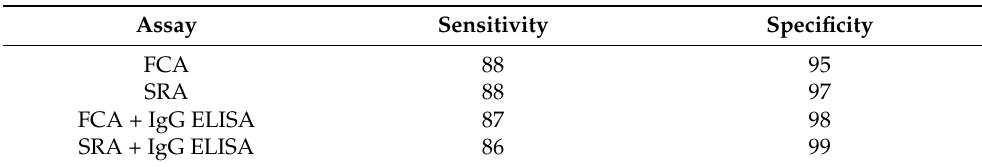
Table 3. Sensitivity and specificity of the FCA and SRA alone and in conjunction with IgG ELISA for 288 patients (131 HIT+ and 157 HIT − ).